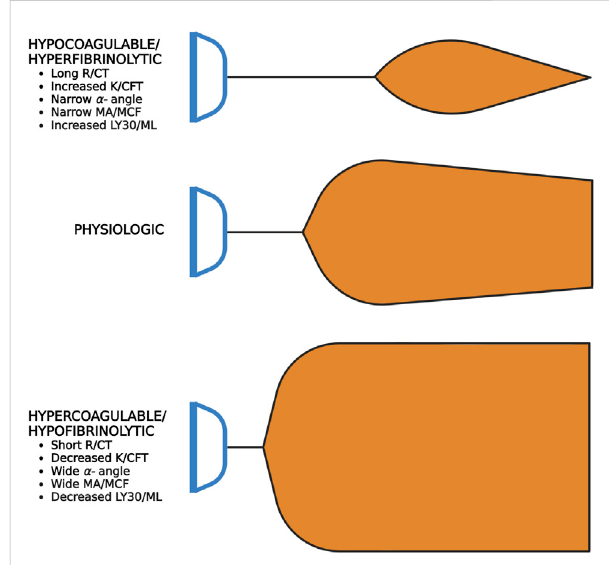
FIGURE 7 Shovel Analogy to Rapidly Interpret TEG/ROTEM Tracings. The top shovel represents the hypocoagulable state marked by a prolonged R/CT,narrow α -angle,narrow MA/MCF, andincreasedlysis with resultant increased LY30/ML. The middle shovel represents physiologic hemostasis marked by normal R/CT, α -angle, MA/MCF, and LY30/ML. Mild narrowing after the MA demonstrates physiologic fi brinolysis. The bottom shovel represents the hypercoagulable state denoted by decreased R/CT, wide α -angle, wide MA/MCF, and decreased LY30/ML. Abbreviations: R, Reaction time; CT, Clotting Time; K, Kinetics; CFT, Clot Formation Time; MA, Maximum Amplitude; MCF, Maximum Clot Firmness; LY30/60, Lysis at 30/ 60 min; ML, Maximum Lysis. Created with